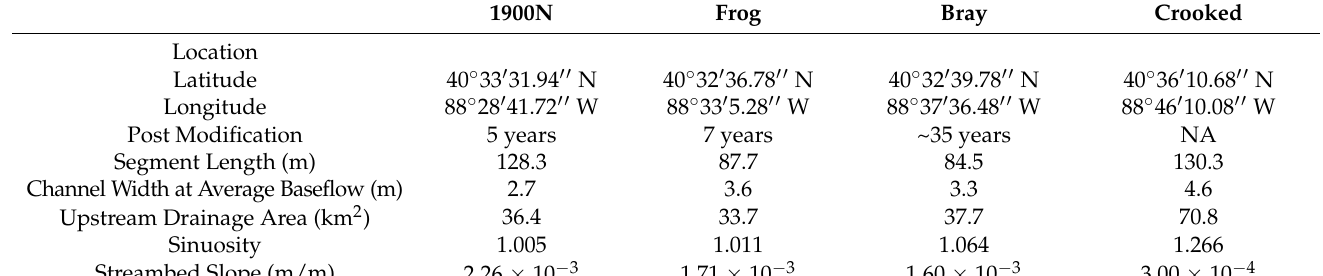
Table 1. Stream characteristics.